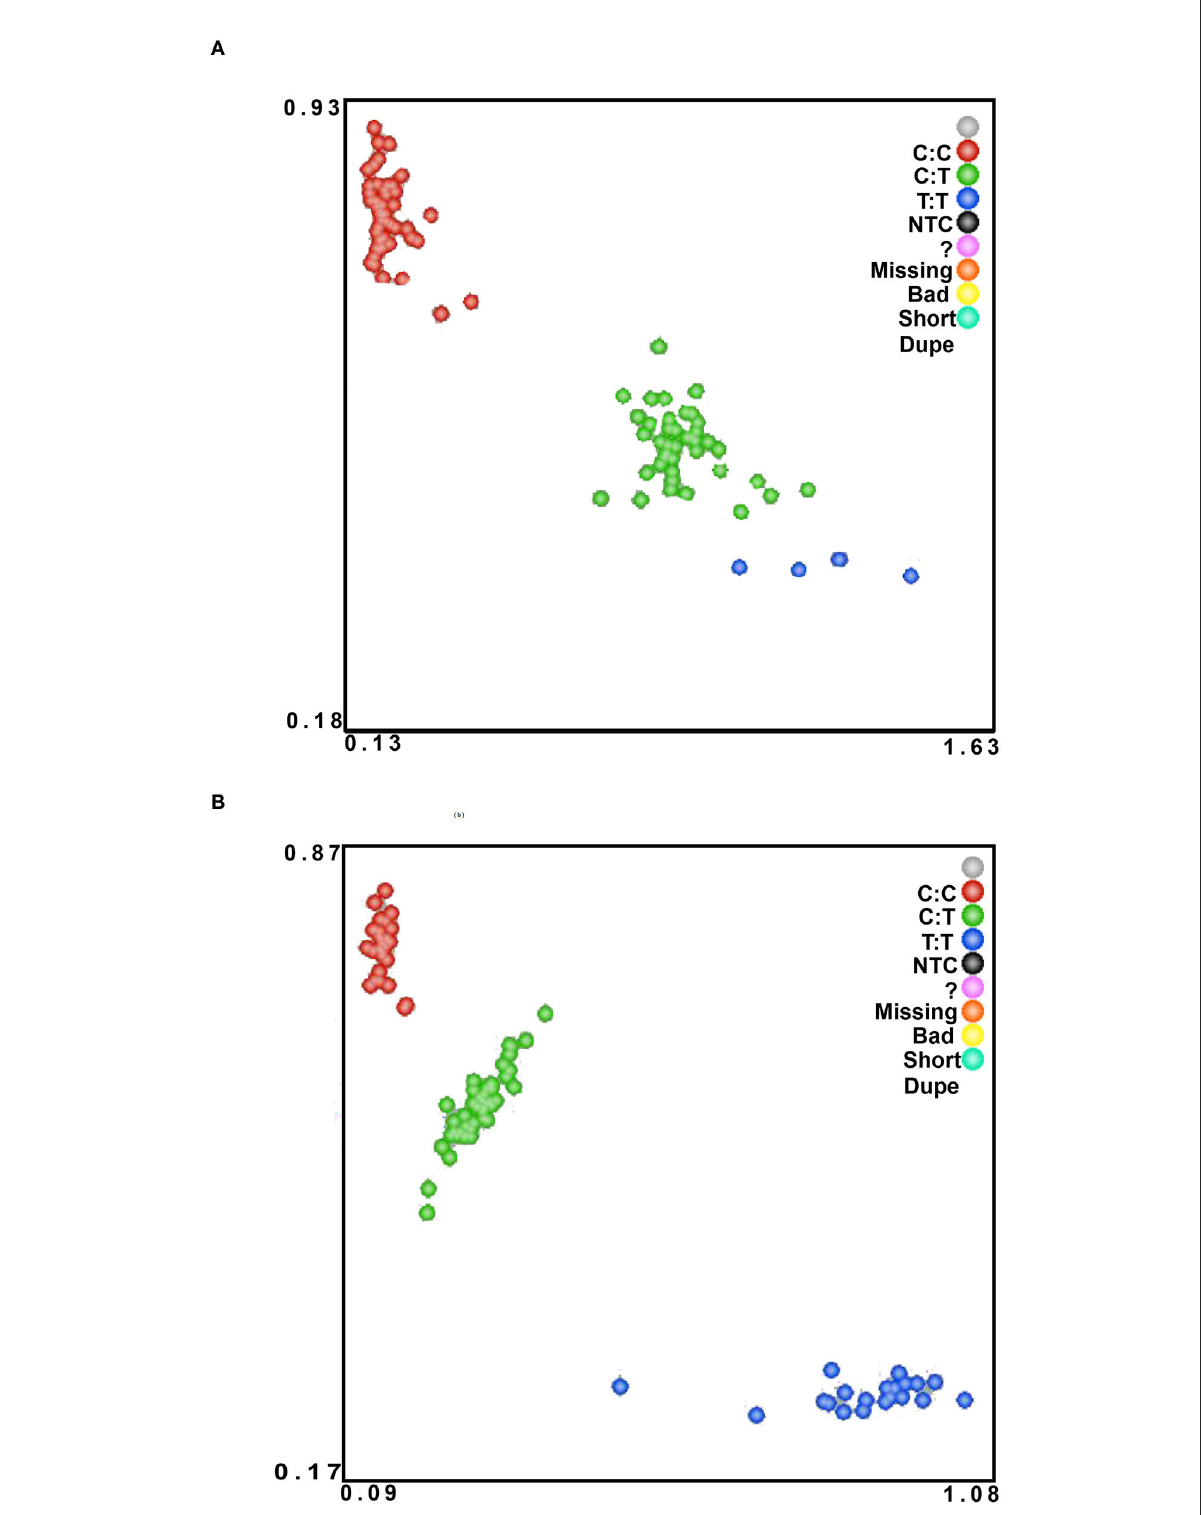
FIGURE3 The KASPar method was used to genotype Hu sheep NC_040257.1:c.625T > C (A) and NC_040261.1:g.9905T > C (B) SNPs in the experimental population. The color of the dots indicates the result of genotyping; green, red, and blue in the figure indicate three different genotypes.